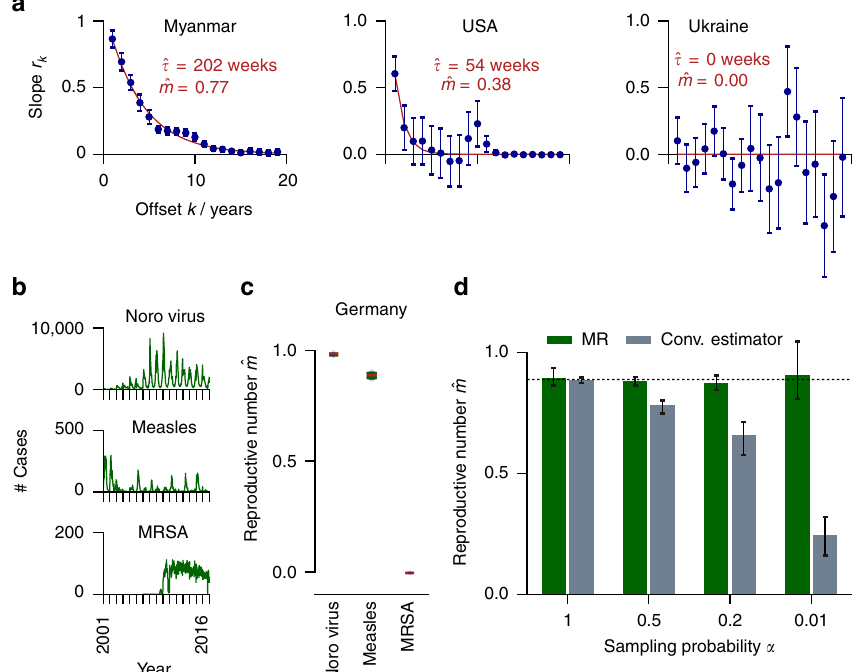
Fig. 2 Disease propagation. In epidemic models, the reproductive number m can serve as an indicator for the infectiousness of a disease within a population, and predict the risk of large incidence bursts. We have estimated ^ m from incidence time series of measles infections for 124 countries worldwide (Supplementary Note 9); as well as noroviral infection, measles, and invasive meticillin-resistant Staphylococcus aureus (MRSA) infections in Germany. a MR estimation of ^ m is shown for measles infections in three different countries. Error bars here and in all following fi gures indicate 1SD or the corresponding 16 to 84% con fi dence intervals if asymmetric. The reproductive numbers ^ m decrease with the vaccination rate (Spearman rank correlation: r = − 0.342, p < 10 − 4 ). b Weekly case report time series for norovirus, measles and MRSA in Germany. c Reproductive numbers ^ m for these infections. d When arti fi cially subsampling the measles recording (under-ascertainment), conventional estimation underestimates ^ m the correct value. Both estimators return the same ^ m under full